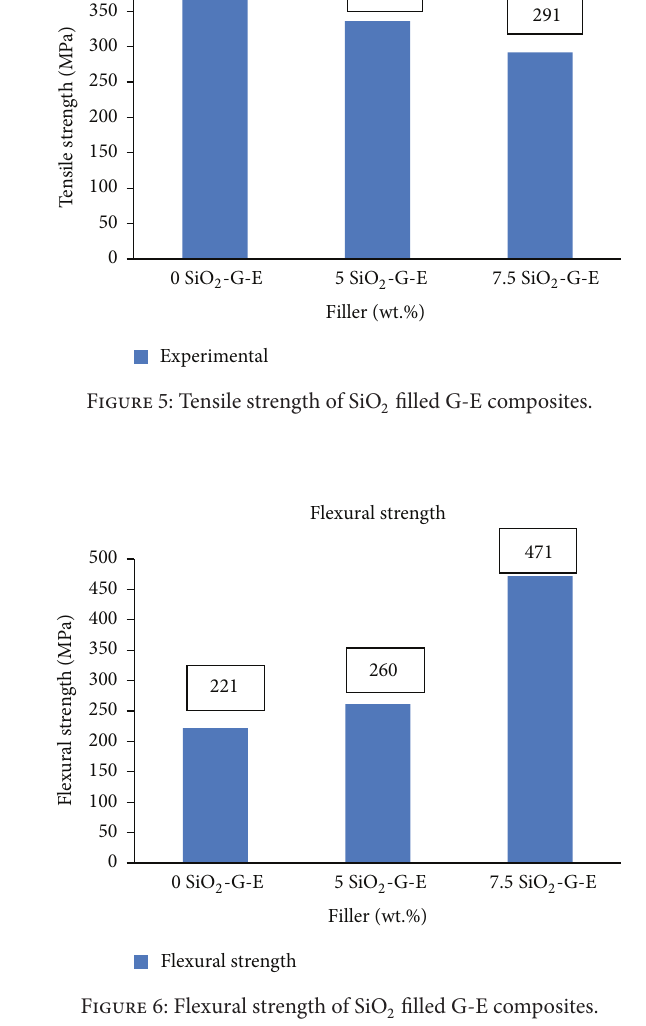
Figure 6: Flexural strength of SiO 2 filled G-E composites.